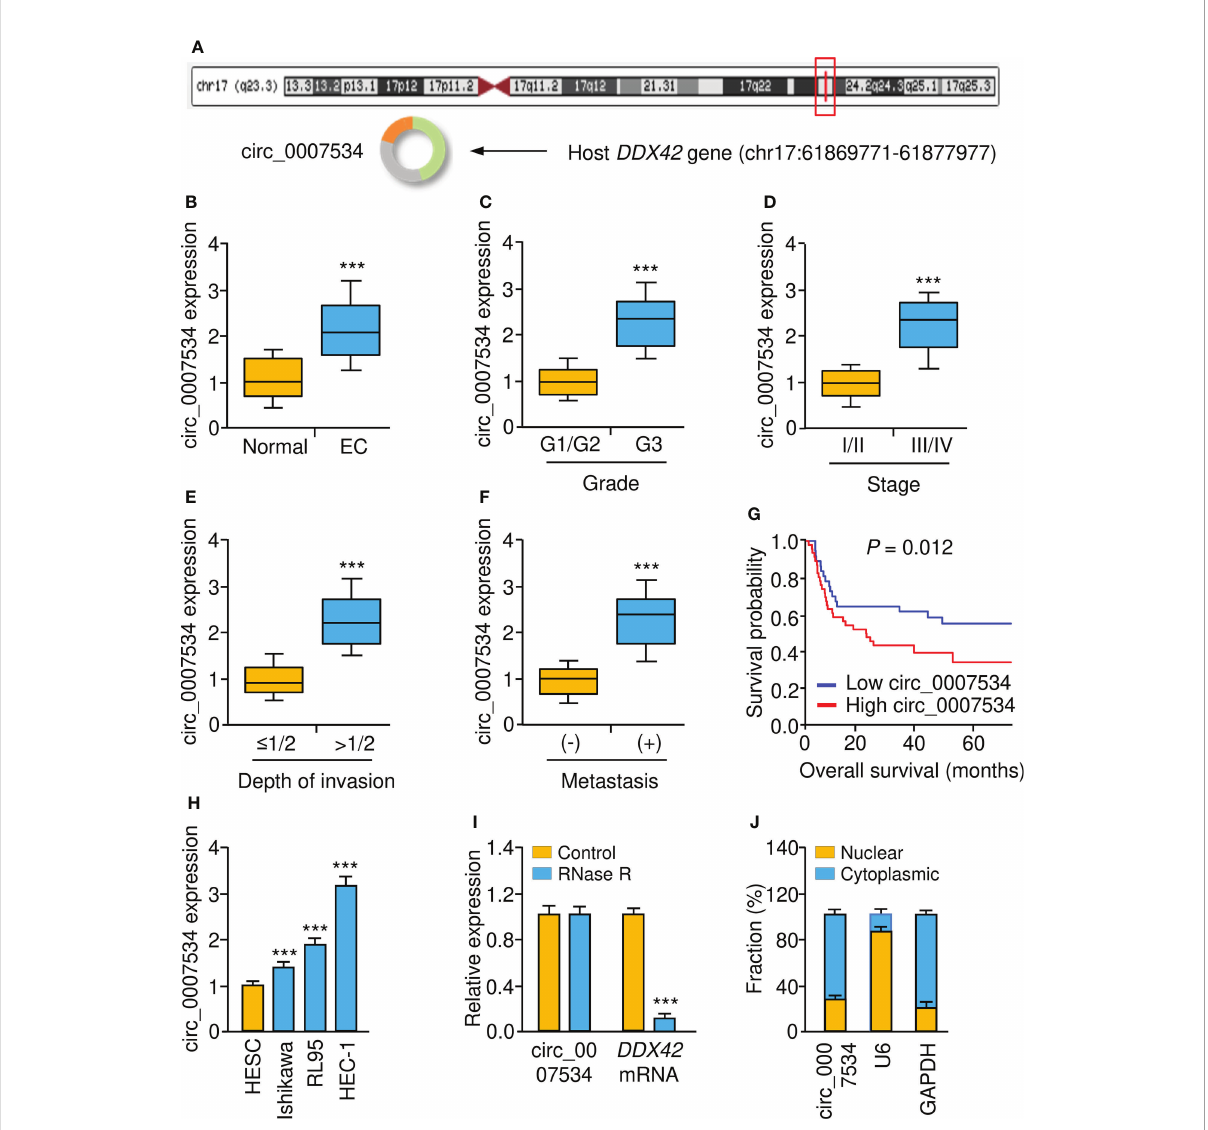
FIGURE 1 Upregulation of circ_0007534 is correlated with the progression and poor prognosis of endometrial cancer. (A) Diagram showed the formation of circ_0007534. (B) Real-time PCR detection of circ_0007534 expression in endometrial cancer and normal tissues. (C-F) Circ_0007534 expression in endometrial cancer (EC) patients with different tumor grades (C) , tumor stage (D) , depth of invasion (E) , and lymph node metastases (F) was examined using real-time PCRs. (G) The overall survival of endometrial cancer patients who had higher or lower circ_0007534 expression. (H) Circ_0007534 expression in endometrial cancer cells and normal cells. (I) Circ_0007534 was resistant to RNase R treatment in endometrial cancer cells. (J) The levels of circ_0007534 in the cytoplasm and nucleus of HEC-1 cells were examined using real- time PCR analysis. *** P <